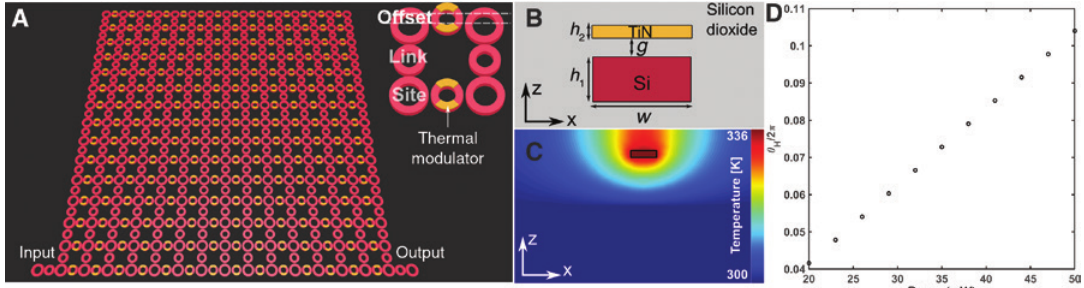
Figure 2: Making a photonic analog of a 2D electron system. (A) Schematics of the coupled 15 × 15 coupled ring resonators. The inset shows a unit cell configuration. Resonators are made of silicon placed in silicon dioxide environment. (B) Cross-section of the link waveguide integrated with thermal heater ( w = 510 nm, h = 100 nm, g = 600 nm). (C) The temperature distribution around the waveguide (outlined by black contour) for 20 mW input power. (D) The h 2 acquired phase shift (in fractions of 2 π ) for a heater length of 15 μ